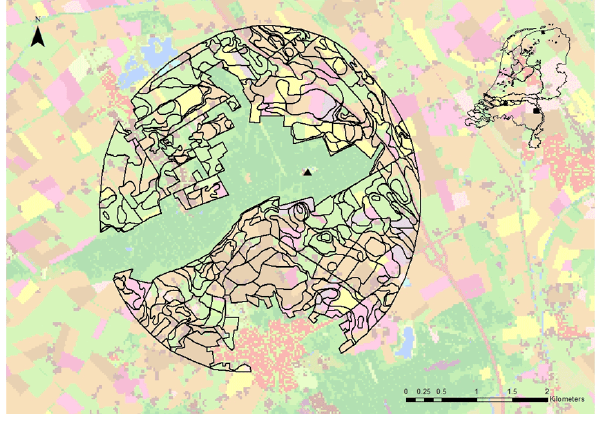
Figure 9. Location and topography of the Vierlingsbeek area in the Netherlands. The black triangle is the location of the drinking water well.